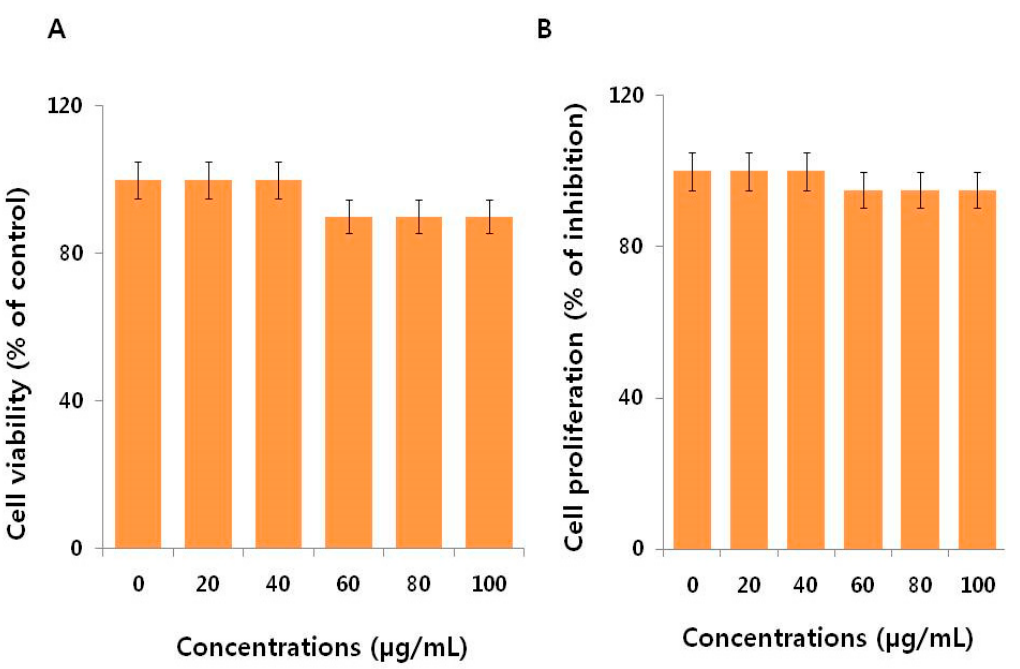
Figure 4. Cell viability and proliferation assessment of myricetin in NIH3T3 cells. ( A ) Viability of NIH3T3 cells was determined 24 h after exposure to different concentrations of myricetin using the CCK-8 assay. ( B ) Cell proliferation assay was performed using the BrdU cell proliferation assay. The results are expressed as the mean ± standard deviation of three independent experiments.